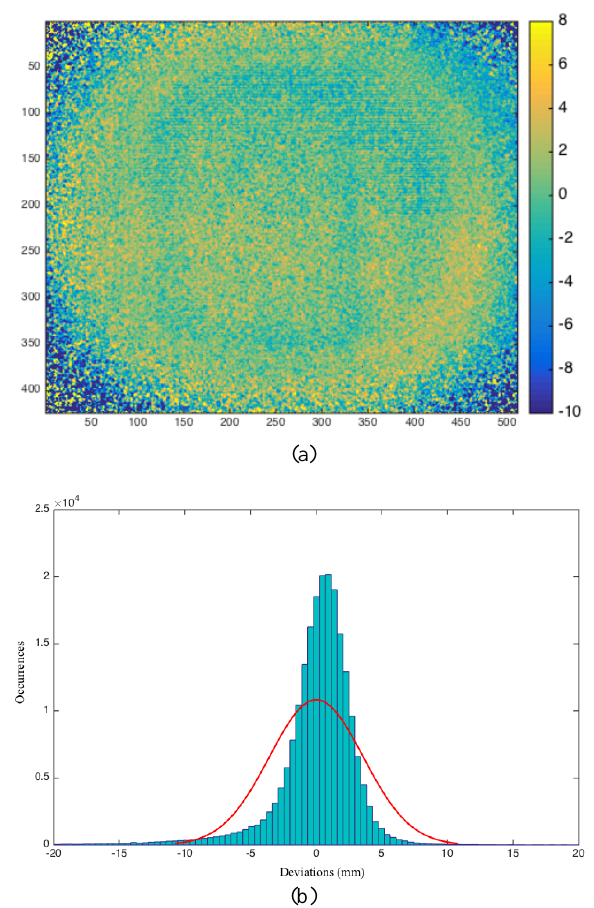
Figure 12. Residual distances between points and a fitted plane at the range of 1,25 m: (a) map with colorbar in millimeters; (b) corresponding